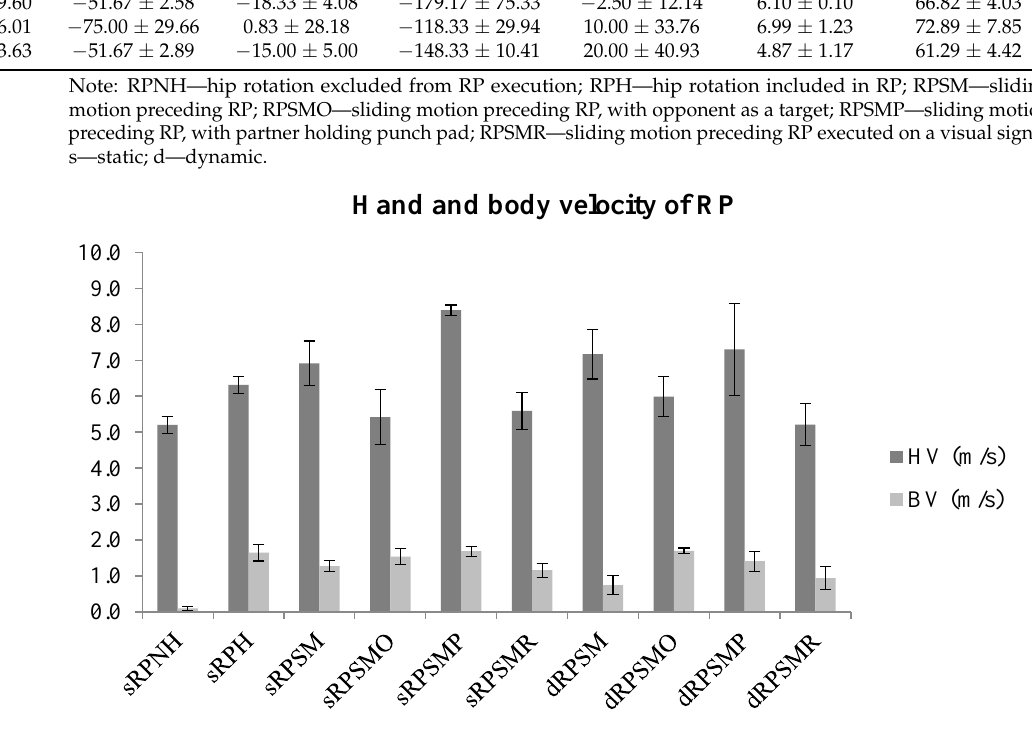
Figure 3. Change in maximum hand and body velocity (m/s) in the ten test modalities of reverse punch.